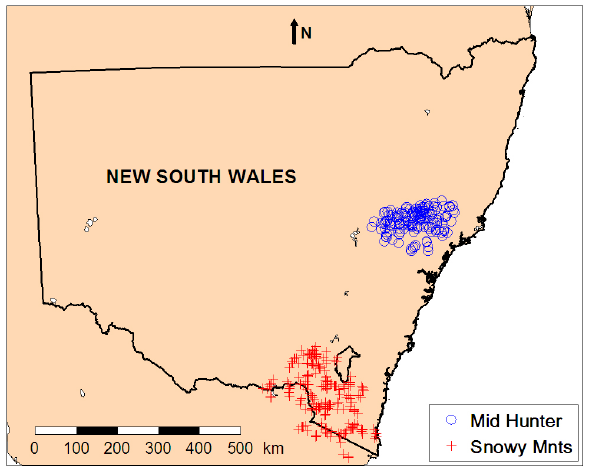
Figure 2: Location of the two study areas in